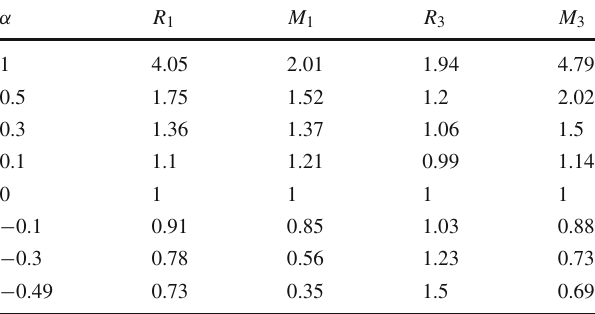
Table 1 Ratios of numerical values of the radius and masses for the different types of stars (for example R i , i = { 1 , 3 } denotes a radius ratio for n = 1, n = 3, respectively) for various values of